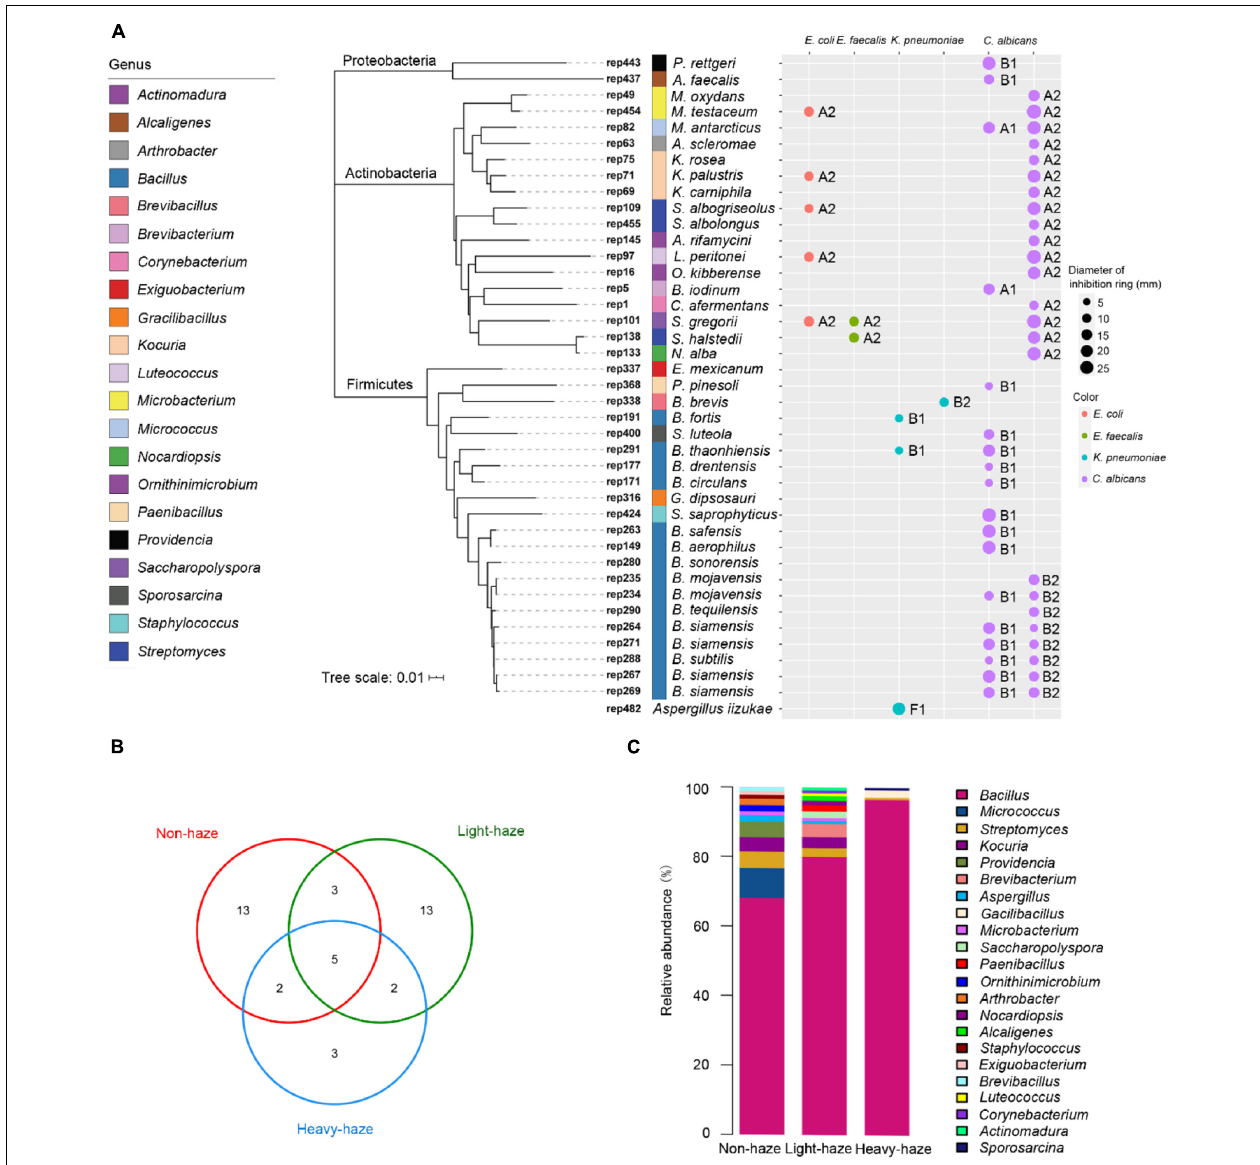
FIGURE 6 | Antimicrobial activity of microbial representatives. (A) Phylogenetic tree of microbial isolates based on bacterial 16S rRNA sequences using neighbor-joining methods and activity patterns of microbial representatives with antimicrobial activity. (B) Venn diagram indicating unique representatives during various haze-level days. (C) Bar plot indicating relative abundances of genera with antimicrobial